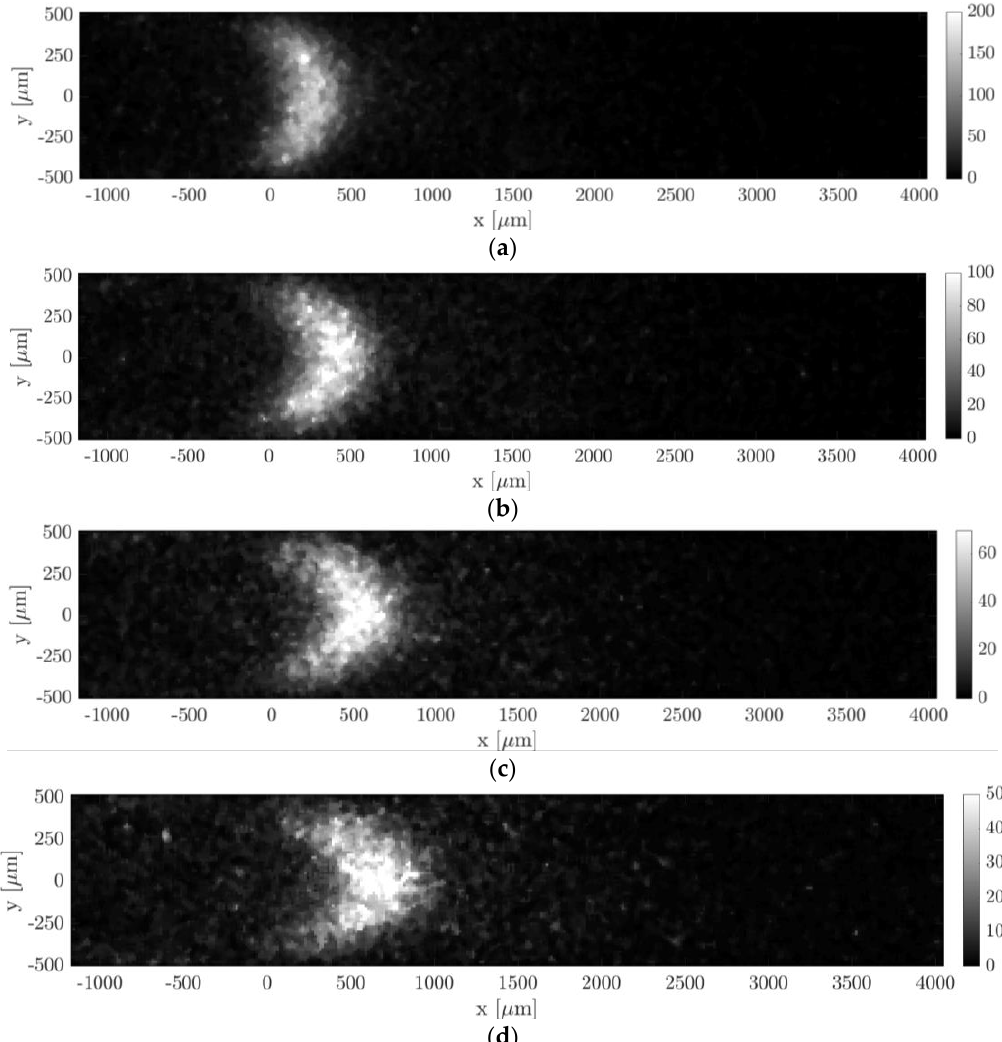
Figure 15. MTV acquisitions of argon–acetone flow with 𝜒 = 20%: ( a ) Δ𝑡 = 20 µs, 𝑝 𝑚 = 6904 Pa, and Δ𝑝 = 371 Pa; ( b ) Δ𝑡 = 30 µs, 𝑝 𝑚 = 6620 Pa, and Δ𝑝 = 367 Pa; ( c ) Δ𝑡 = 40 µs, 𝑝 𝑚 = 6337 Pa, and Δ𝑝 = 362.8 Pa; and ( d ) Δ𝑡 = 50 µs, 𝑝 𝑚 = 6071 Pa, and Δ𝑝 = 358.6 Pa. The recording parameters are: 𝑁 𝑙 = 100, 𝑁 𝑖 = 20, 𝐺 = 100%, and Δ𝑡 𝑔𝑎𝑡𝑒 = 100 ns. The acquisitions are made with a 4 × 4 binning. The laser pulse energy was varying between 20 and 30 µJ.